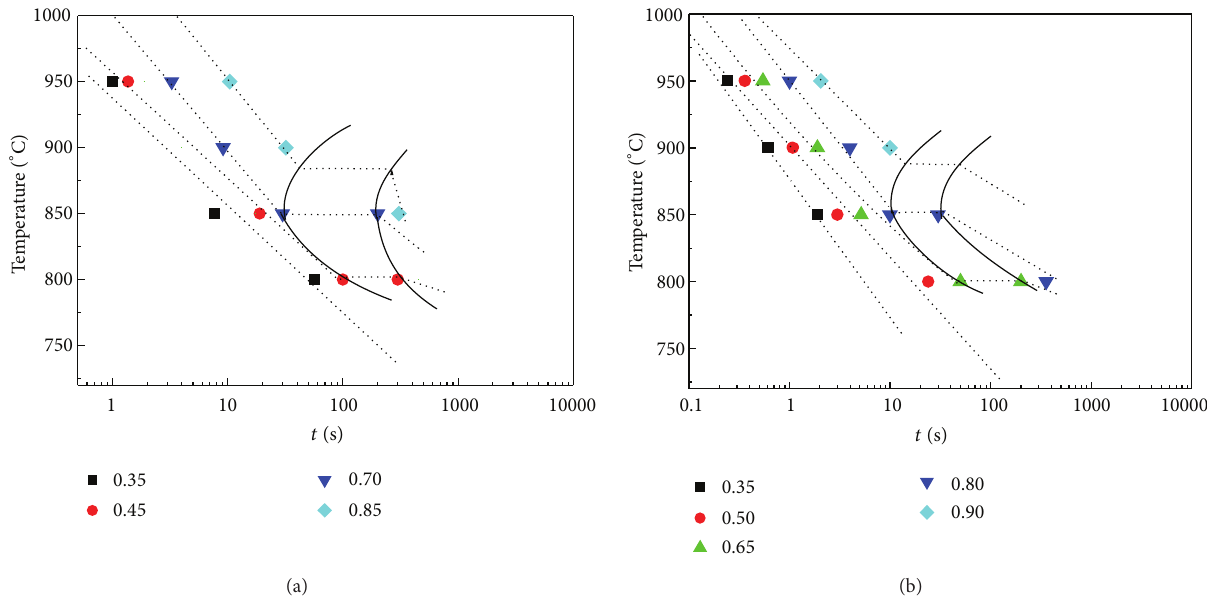
Figure 4: RPTT diagrams for the tested steel. (a) True strain 𝜀 = 0.22 ; (b) true strain 𝜀 = 0.35